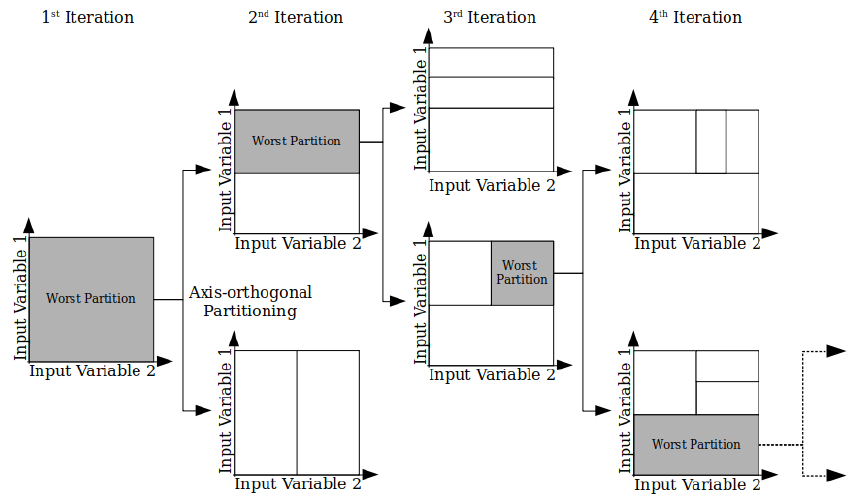
Figure 1. Local Linear Model Tree (LOLIMOT) partitioning procedure for two-dimensional input spaces. Adapted from [28] ⁠ .